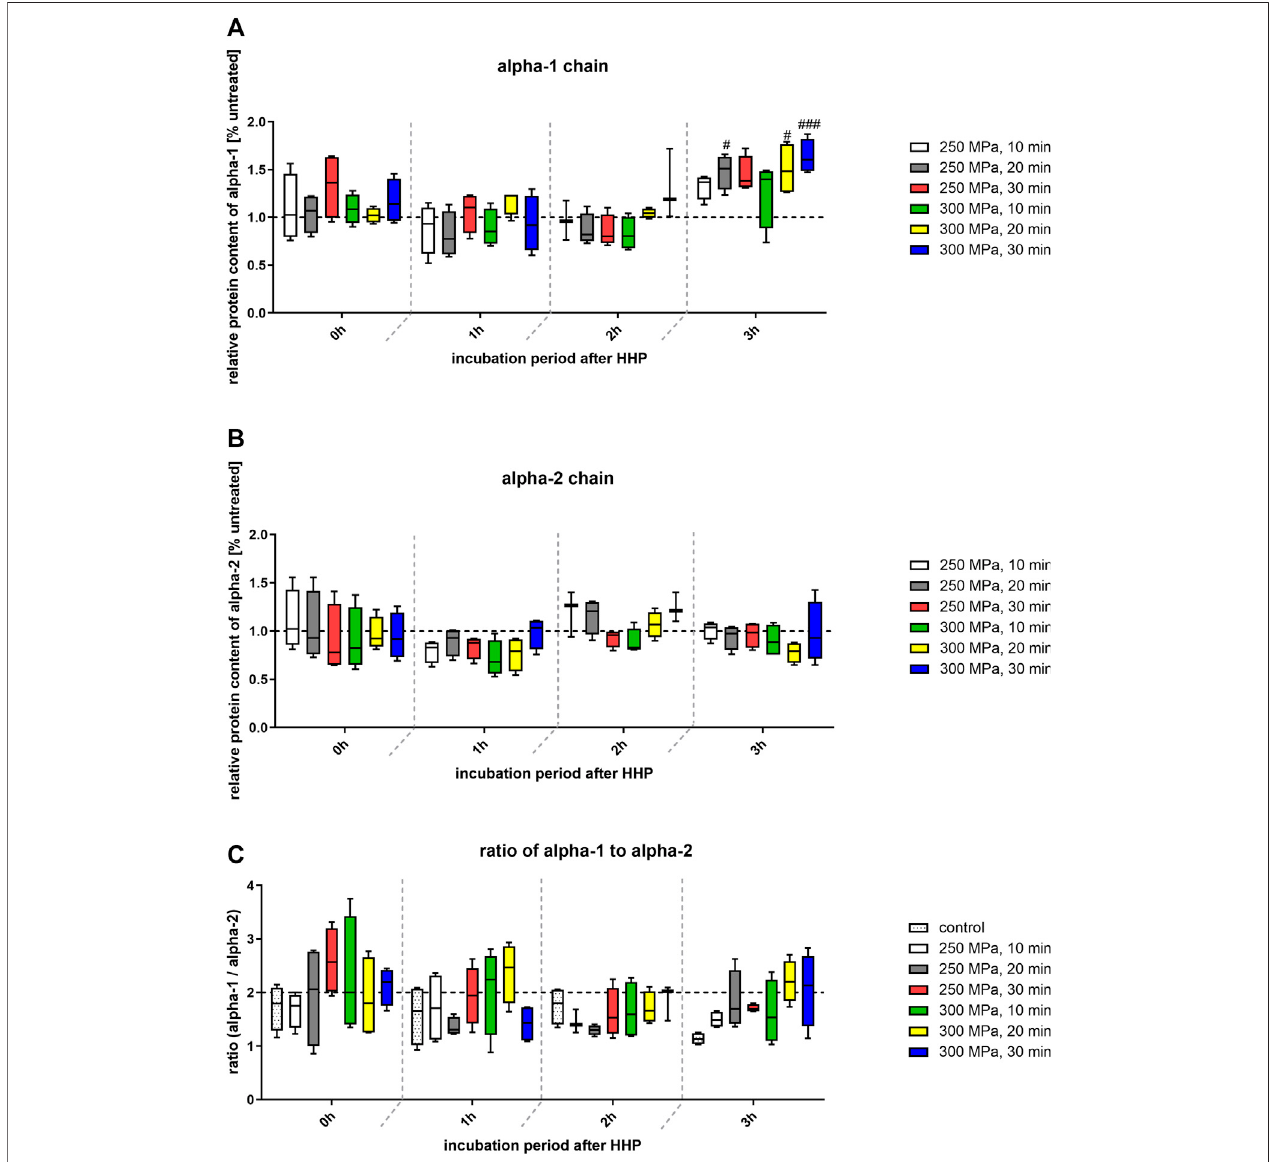
FIGURE 7 | (A) Quanti fi cation of band intensity of alpha-1 chains from SDS-PAGE relative to intensity of control bands (dotted line at y (cid:2) 1). (B) Quanti fi cation of bandintensityofalpha-2chainsfromSDS-PAGErelativetointensityofcontrolbands(dottedlineaty (cid:2) 1). (C) Ratioofpixelsofalpha-1andalpha-2bands.Dottedlineat y (cid:2) 2 shows the expected value of calculation. Statistical analysis was performed using two-way-ANOVA ( n (cid:2) 4) with Bonferroni ’ s multiple comparison test as post hoc test. Signi fi cant differences to untreated control: # p ≤ 0.05; #### p ≤ 0.0001.